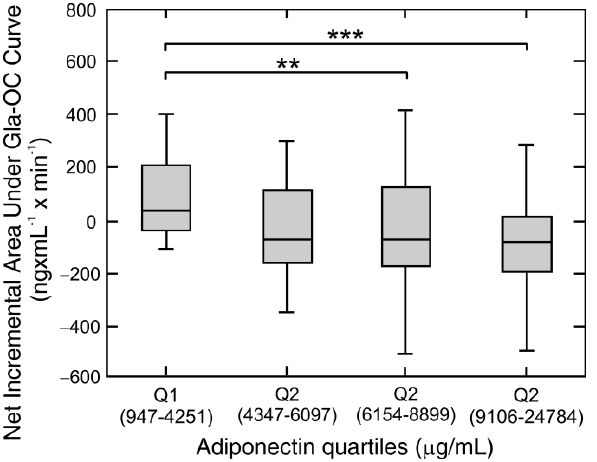
Figure 6. Net incremental areas under Gla-OC and quartiles of serum adiponectin concentration. Variation of values of net incremental areas (Net AUC) under carboxylated osteocalcin (Gla-OC) during a high fat mixed meal tolerance test with the quartile of adiponectin serum concentration (range of values for each quartile is in brackets) in combined non-obese ( n = 24) and obese ( n = 70) subject study groups. Values are presented as medians (line), upper and lower quartile (box), and extremes (whiskers). Statistics: Kruskal-Wallis and Dunn test. Significant differences are indicated as follows: ** p < 0.01 for difference in values of Gla-OC Net AUC between quartile 1 and quartile 3 of serum adiponectin concentration. *** p < 0.001 for difference in values of Gla-OC Net AUC between quartile 1 and quartile 4 of serum adiponectin concentration. 4. Discussion Our studies are the first to show the effect of a high fat mixed meal on the blood level of not only total osteocalcin, but also its carboxylated and undercarboxylated form, in obese insulin resistant subjects. Studies performed so far have shown that different nutrients could influence bone turnover [16 – 22]. However, as a marker of bone formation, blood total osteocalcin has been used. In our studies, we focused on the effect of more physiological intake of nutrients during a high fat mixed meal on the blood levels of the carboxylated and undercarboxylated form of osteocalcin in non-obese healthy individuals as well as in insulin resistant obese volunteers. We observed a suppression of total osteocalcin (the sum of carboxylated and undercarboxylated osteocalcin) serum levels after 2 and 6 h of mixed meal consumption in healthy volunteers. Our results appear to agree with previous studies [26] Namely, Henriksen et al. indicated that fat (35 g) and protein (35 g) present a tendency to suppress total blood osteocalcin concentration during 3 h of food consumption. In our study, we observed a statistically significant decrease of total osteocalcin, which could be associated with the fact that our breakfast consisted of three combined nutrients (protein, fat, and saccharides) and its fat content was approximately 2.5 times higher (83.7 g vs 35 g) than in the study reported by Henriksen, whereas protein content was comparable [26]. Regarding the suppression of total serum osteocalcin levels after 6 h of the HFMTT, similar results were also noticed in studies by Henriksen, especially after protein as well as fat intake. In healthy volunteers, we also observed an approximately 10% baseline decrease of serum carboxylated osteocalcin (Gla-OC) level 6 h after breakfast consumption. Gla-OC accumulates mainly in bone (binding to the hydroxyapatite lattice), and only approximately 15% of Gla-OC is released into the bloodstream. Thus, a decrease in serum Gla-OC concentration after breakfast could suggest bone turnover in favour of bone formation to maximize skeletal strength and bone mass when nutrition is abundant in physiological conditions. Our studies have for the first time demonstrated that a decrease of total and carboxylated osteocalcin after a high fat mixed meal was suppressed in obese individuals who did not develop diabetes and also did not have any fasting and postprandial lipid disturbances. Obese subjects included in the intervention study presented insulin resistance (higher HOMA-IR index) and low grade inflammation (high serum IL-6 and hsCRP concentration) whereas baseline